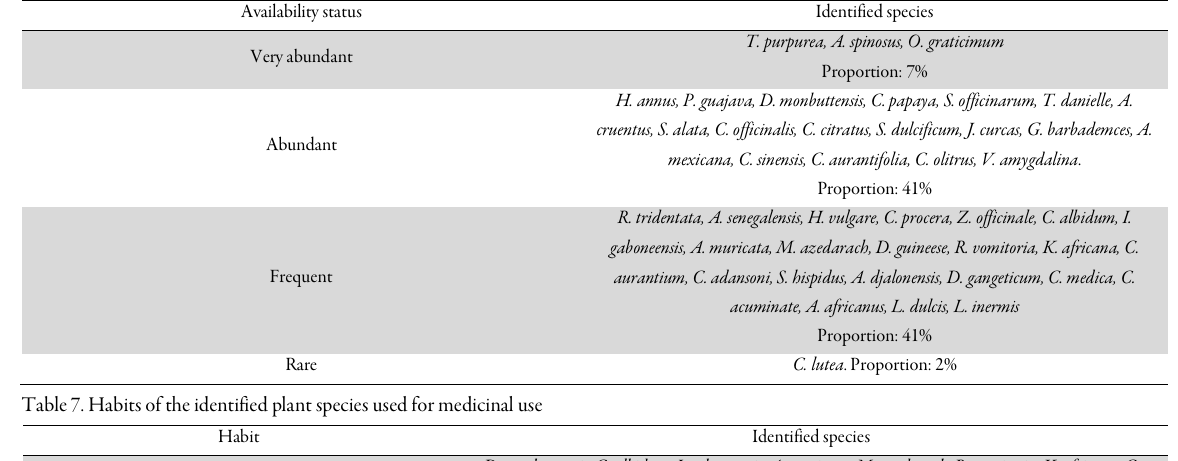
Table 7. Habits of the identified plant species used for medicinal